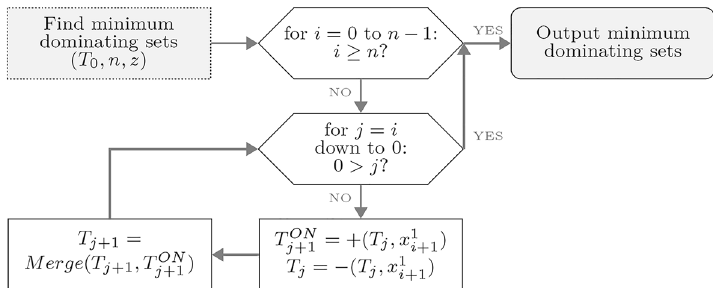
Figure 6. Biomolecular procedure for finding minimum dominating sets.